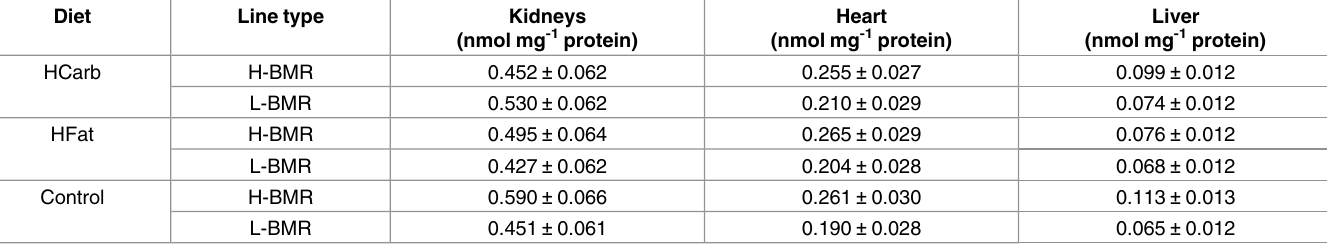
Table 3. MDA concentration in organs of H-BMR and L-BMR type mice fed a HFat, HCarb and Control diets. Data presentedas means ± s.e.m.